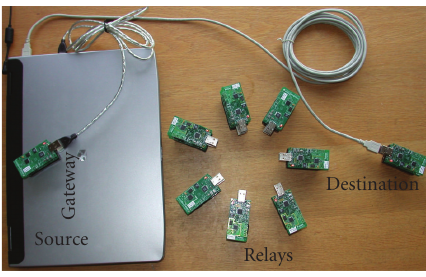
Figure 11: A snapshot of the